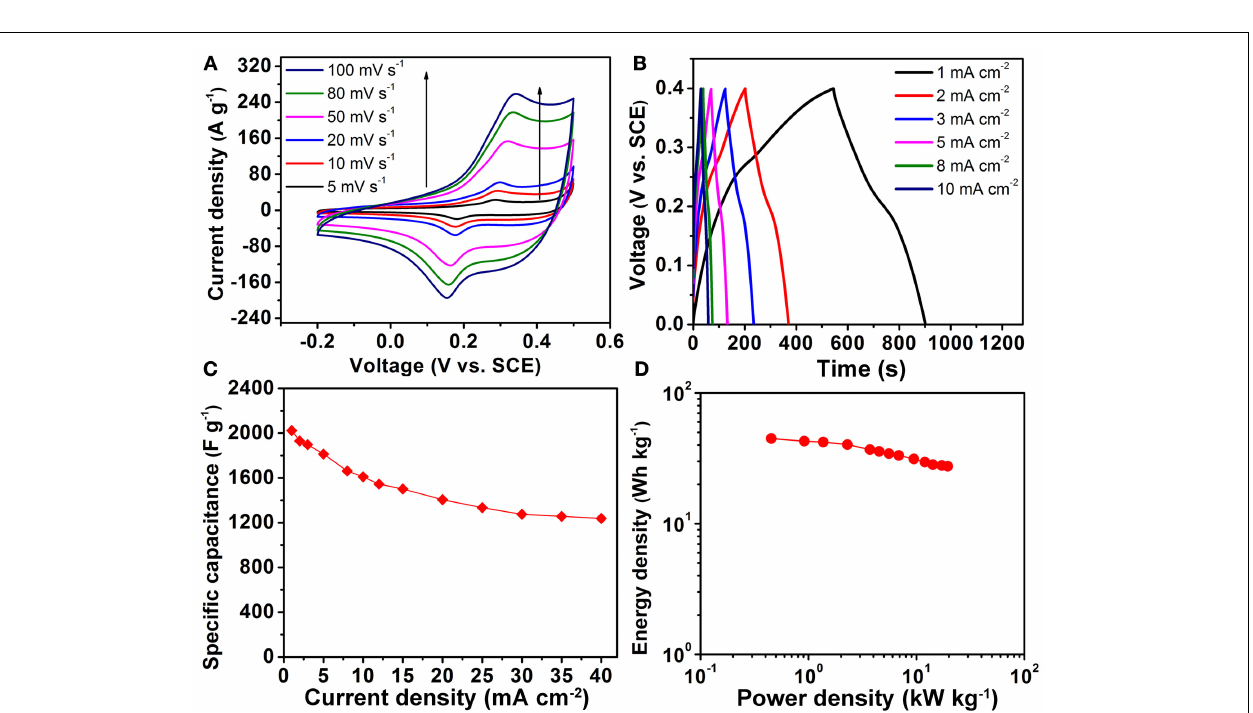
FIGURE 4 | (A) CV curves of Ni–Co–Mn oxide nanoneedle electrodes in 2M KOH electrolyte from 5 to 100mVs (cid:0) 1 . (B) Galvanostatic charge/discharge curves of Ni–Co–Mn oxide electrodes at different current densities in the voltage range between 0 and 0.4V vs. SCE. (C) Specific capacitance as a function of discharge current density. (D) Ragone plot of Ni–Co–Mn oxide nanoneedle electrodes.